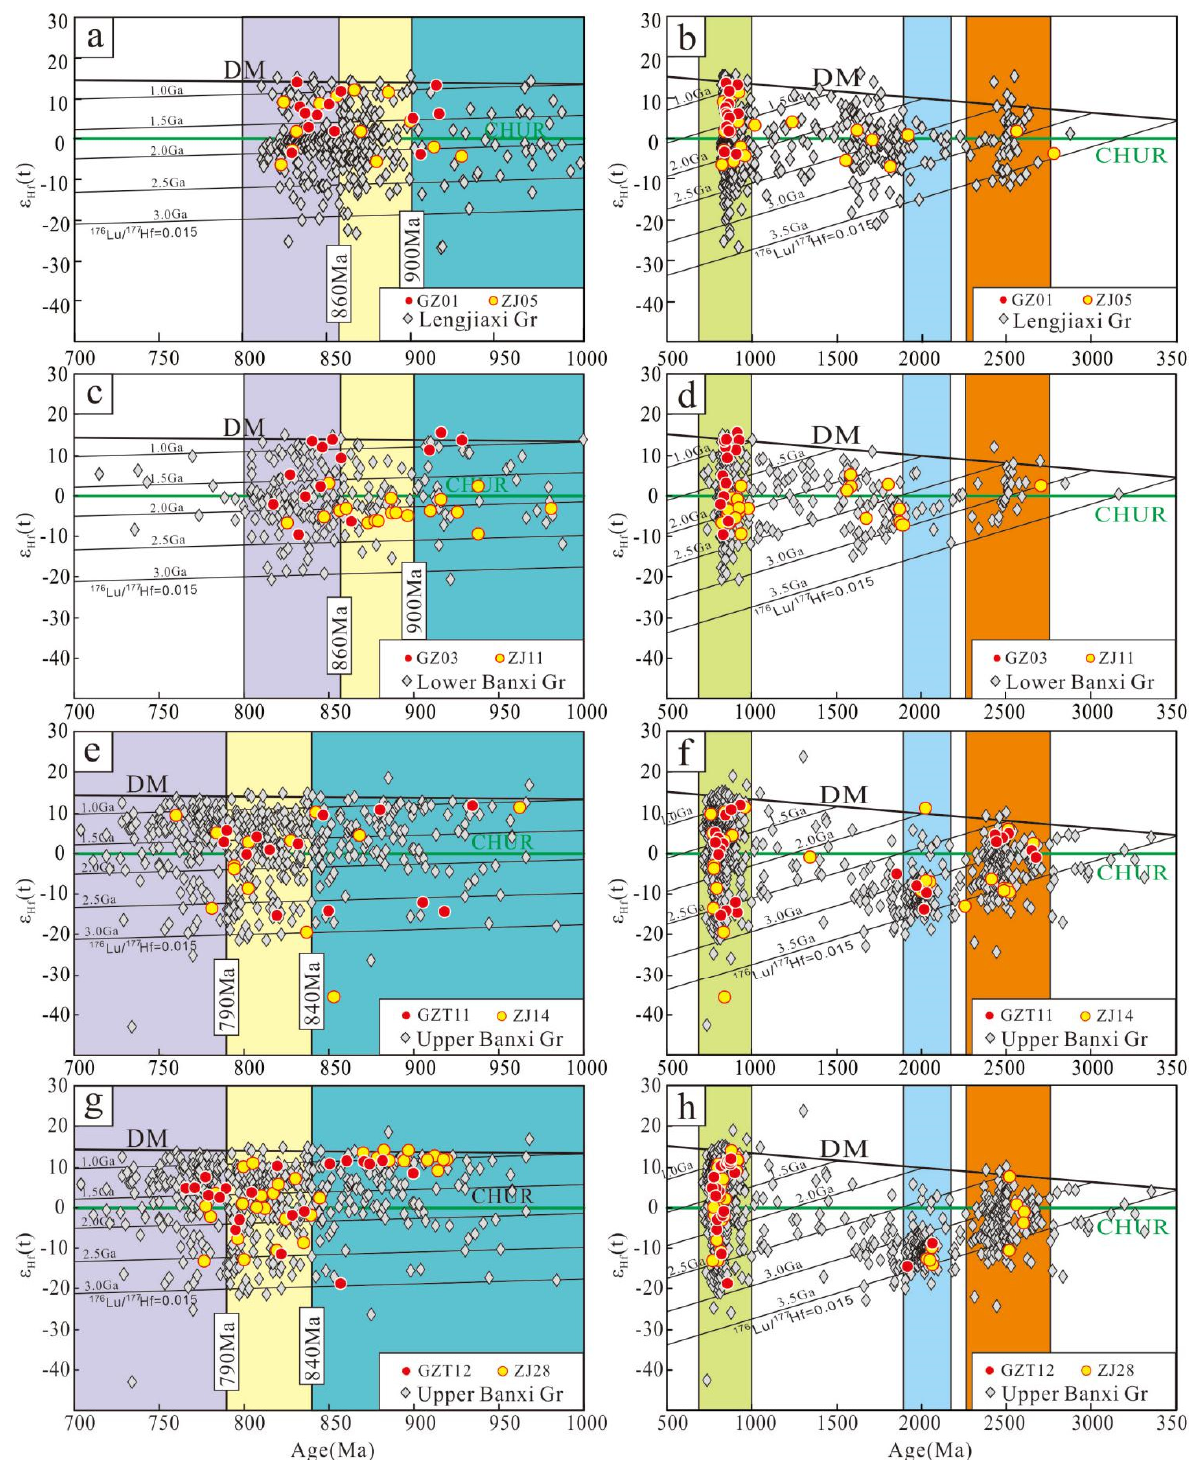
Figure 7. Plots of ε Hf (t) versus U–Pb ages of detrital zircons from the Lengjiaxi Group and its equivalents, upper and lower Banxi Group and their equivalents. Data sources: Lengjiaxi Group and its equivalents [18,49,67–69]; lower Banxi Group and its equivalents [18,68,70–72]; upper Banxi Group and its equivalents [44,45,68,72–76]. ( a , b ) Plots of ε Hf (t) versus U–Pb ages of samples GZ01 and ZJ05; ( c , d ) plots of ε Hf (t) versus U–Pb ages of samples GZ03 and ZJ11; ( e , f ) plots of ε Hf (t) versus U–Pb ages of samples GZT11 and ZJ14; ( g , h ) plots of ε Hf (t) versus U–Pb ages of samples GZT12 and ZJ28.